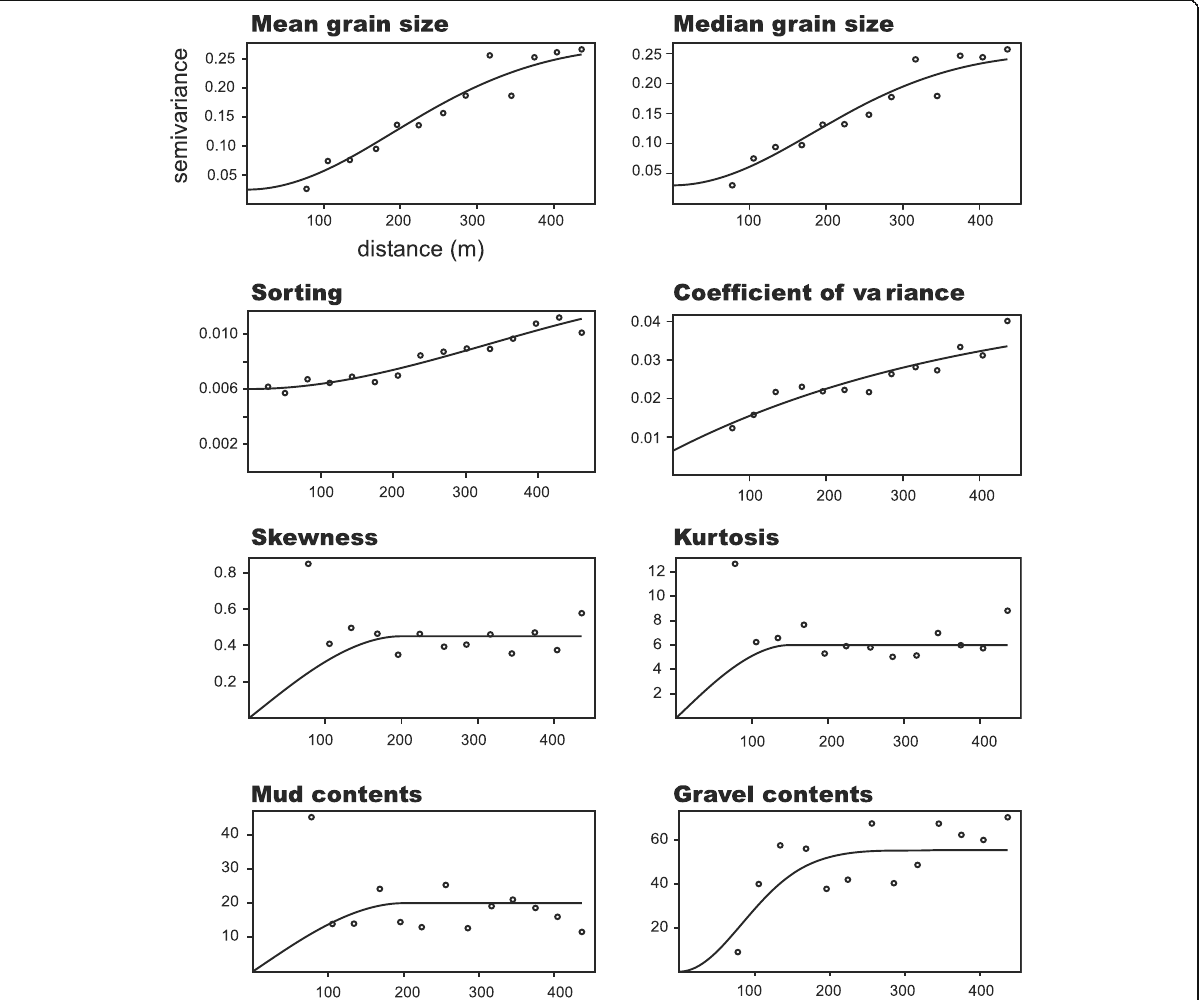
Fig. 6 Semivariograms and fitted variogram models of granulometric parameters. Variogram models were fitted by the least-squares method, and the model that produces the fewest residual errors was chosen from among the Gaussian, spherical, and exponential models. The spherical model was used for mean and median grain-size, sorting, and gravel fractions, the exponential model was used for the CV value, and the Gaussian model was used for skewness, kurtosis, and mud